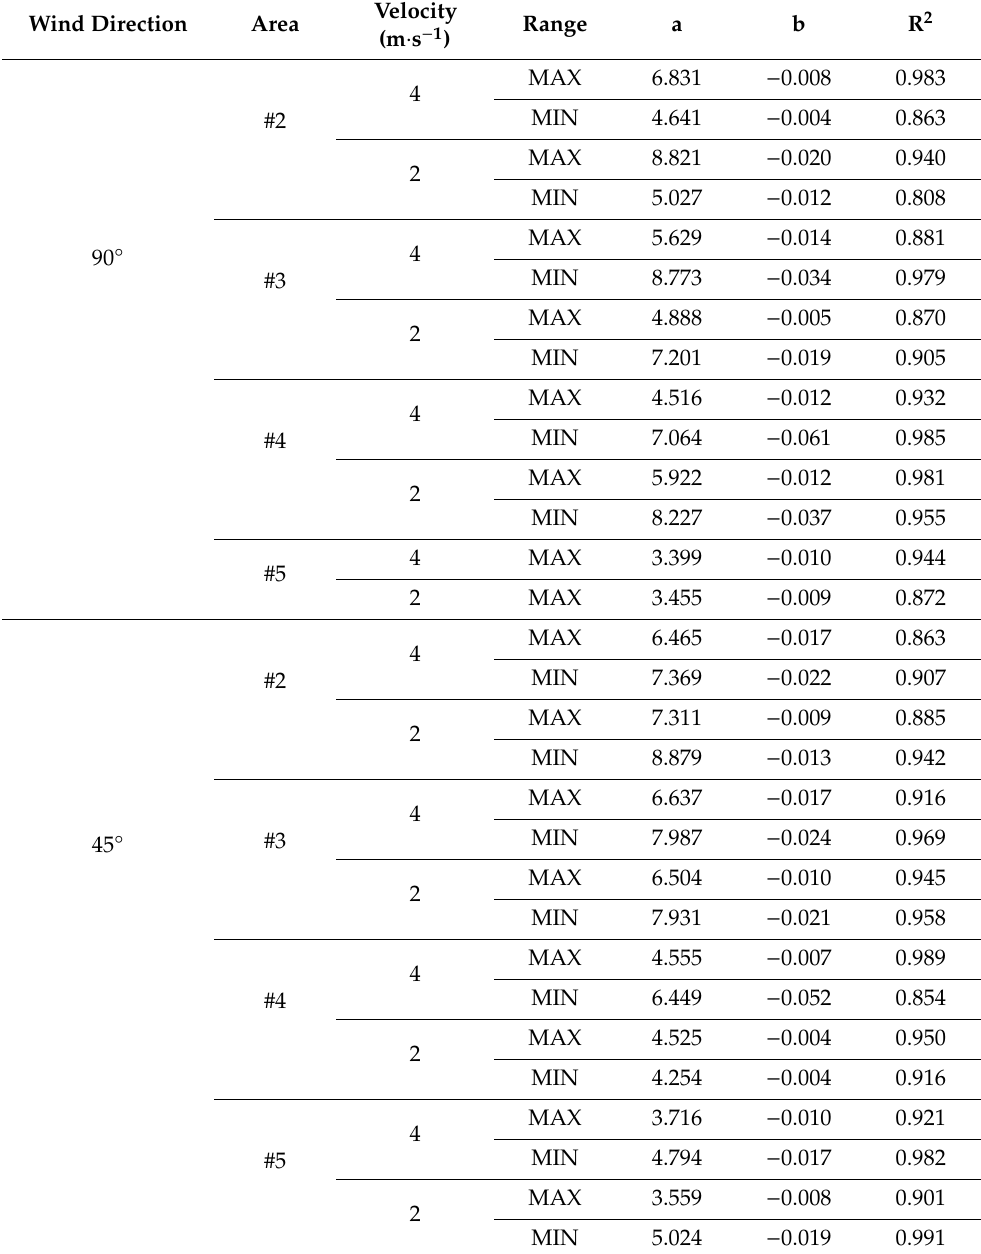
Table 2. Coe ffi cients of the exponential expression of PM10 limiting mass concentrations for Equation